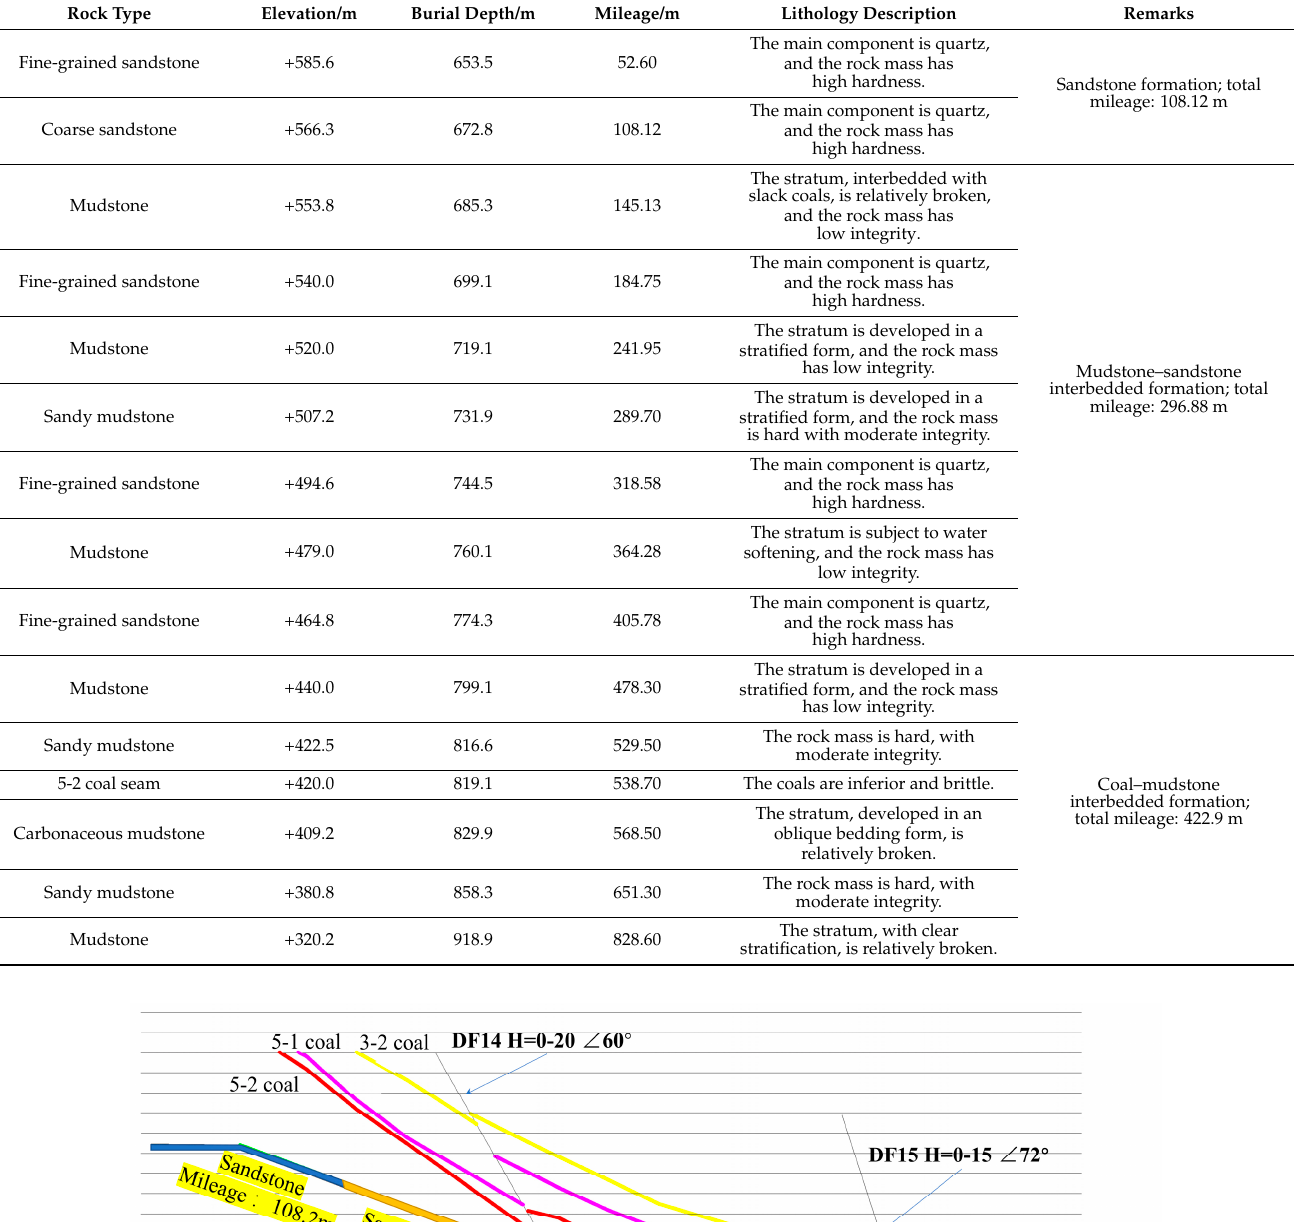
Table 1. Lithology distribution of the surrounding rock in the return air subinclined shaft within different mileages.